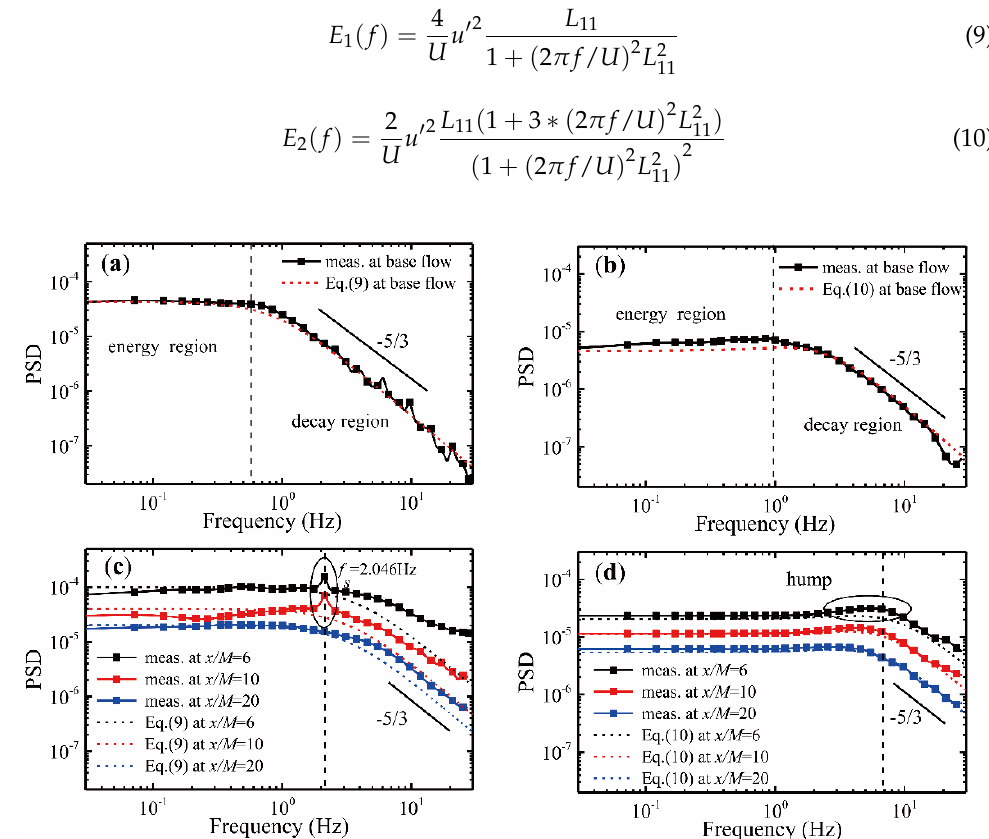
Figure 7. Low-frequency power spectral density (PSD) of fluctuating velocities at mid-depth ( a ) stream-wise and ( b ) transverse components at base flow; ( c ) stream-wise and ( d ) transverse components downstream the grid.